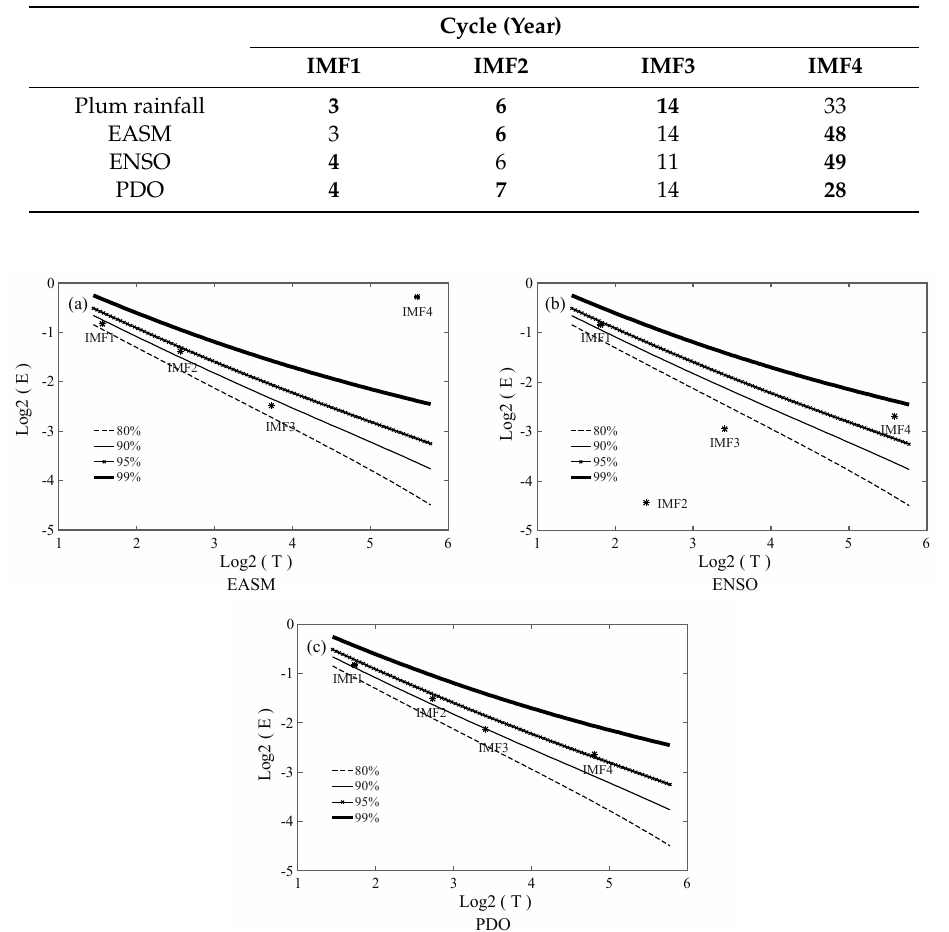
Figure 7. Significance test for the IMFs of ( a ) EASM, ( b ) ENSO, and ( c ) PDO during the period of 1960 to 2012.